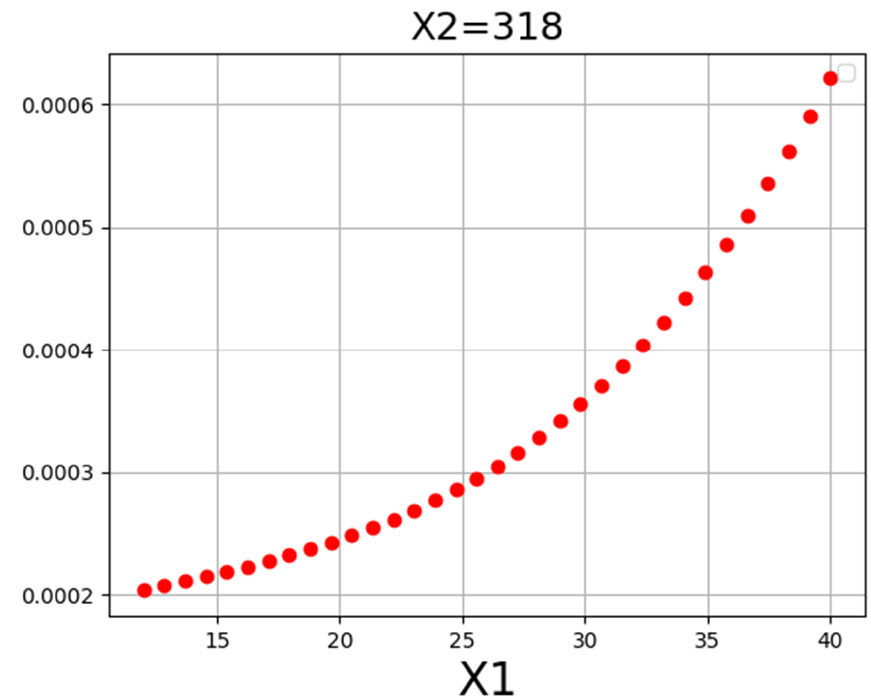
Figure 5. X1 tendency.